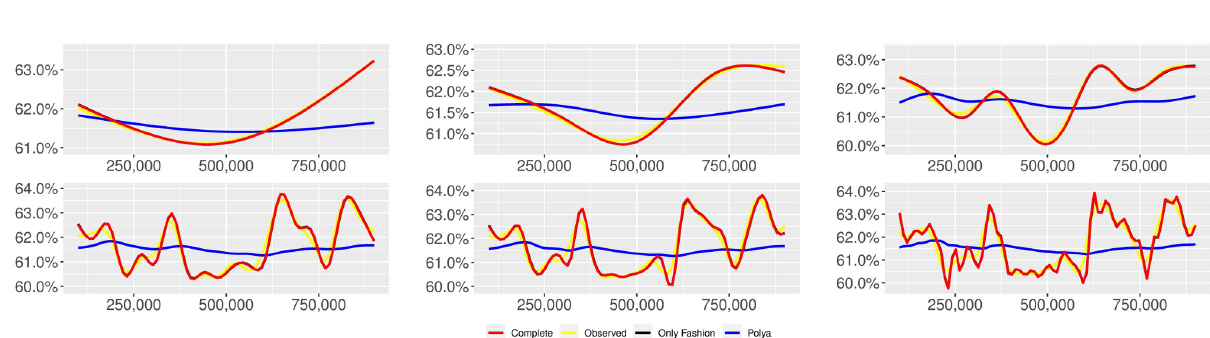
Fig 17. “10 days of traffic” ( T = 0.5, entire, D = 30 00 , S = 100 slots of equal size): Sentiment curves. In each panel, the yellow line is the cubic spline smoothing of the time series of the observed tweets ξ n +1 , together with the default confidence interval (gray), the red line represents the cubic spline smoothing of the time series of the estimated predictive means ^ c (defined in Subsec. 3.2), obtained with the complete RP model, the black and the blue n lines provide similar approximations obtained with the other models: black = Only fashion RP model and blue = Standard Po´lya model. In each panel, the smoothing is obtained with a given number of nodes: k = 3 (top left panel), 5 (top middle panel), 10 (top right panel), 20 (bottom left panel), 30 (bottom middle panel), 50 (bottom right panel).